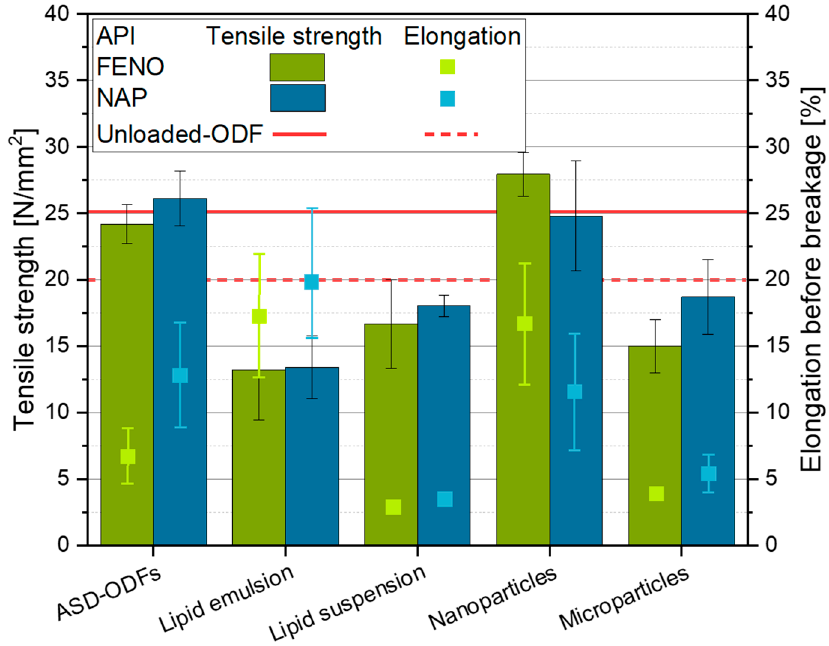
Figure 8. Tensile strength and elongation before breakage for API-loaded ODFs formulated with different strategies, n = 6.